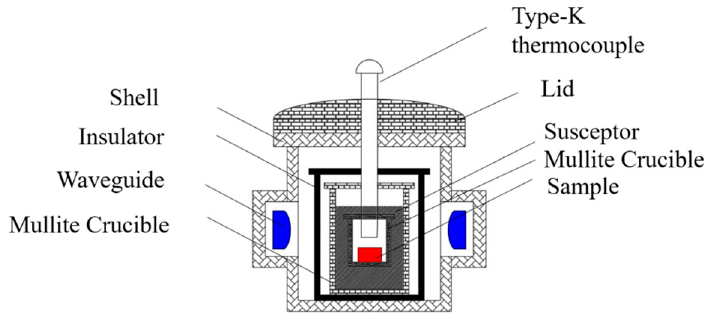
Figure 2. Microwave heating device central